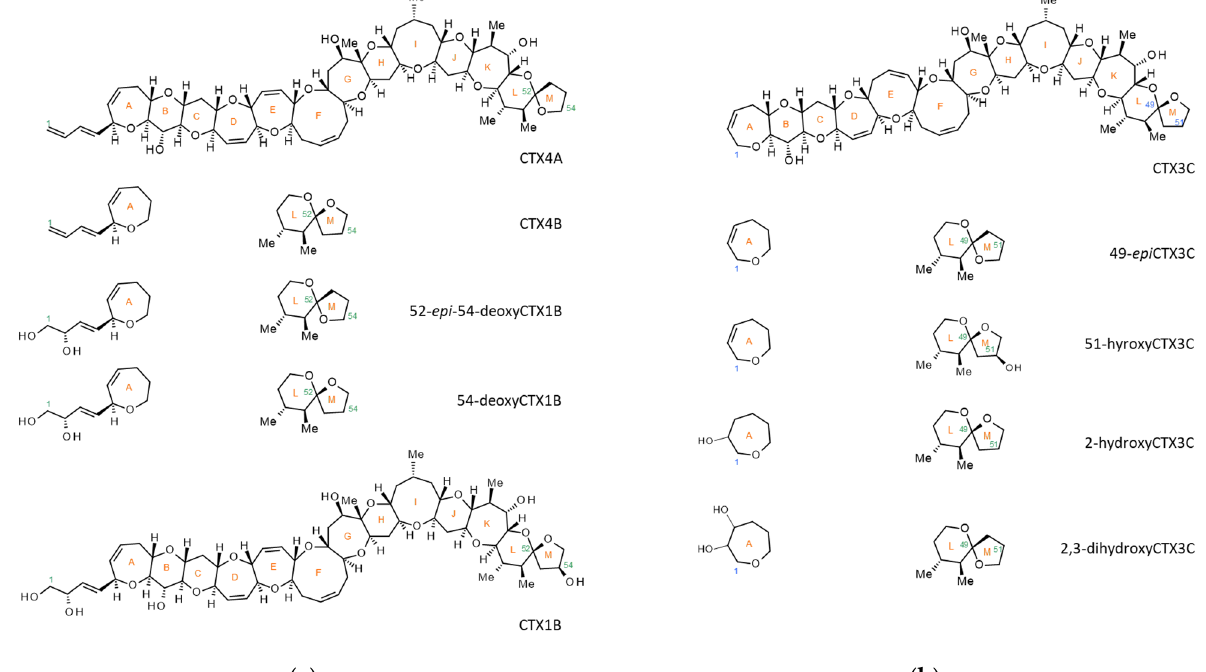
Figure 1. Structures of the representative ciguatoxins (CTXs) reported from the Pacific. ( a ) CTX1B group toxins; ( b ) CTX3C group toxins